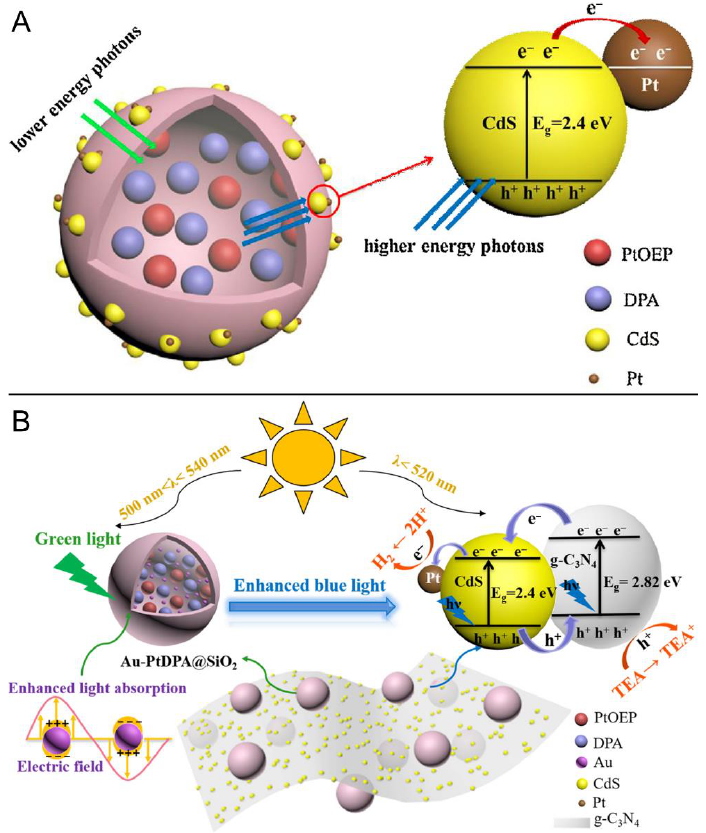
Figure 10. Schematic representations of the photocatalytic mechanisms of ( A ) PtD- PAP@SiO 2 @CdS/Pt photocatalyst and ( B ) Au-PtDPAP@SiO 2 @ g -C 3 N 4 -CdS photocatalyst based on TTA-UC process. Reprinted with permission from ref. [127]. Copyright 2017 Elsevier Ltd. All rights reserved. Reprinted with permission from ref. [128]. Copyright 2019 Elsevier Ltd. All rights re- served.